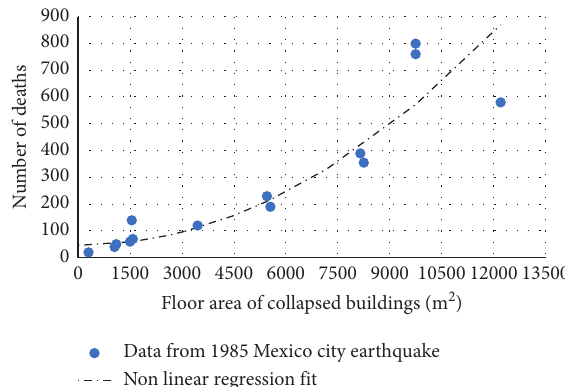
Figure 5: Number of deaths vs area of collapsed